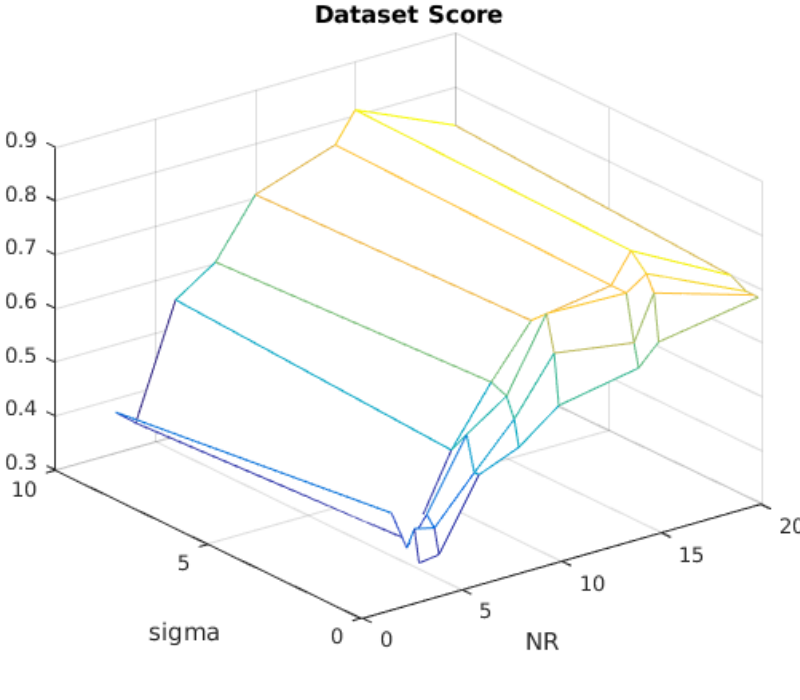
Figure 5. Dataset score; O . R . = 4, ± ∆ R = 2, and N . C . =